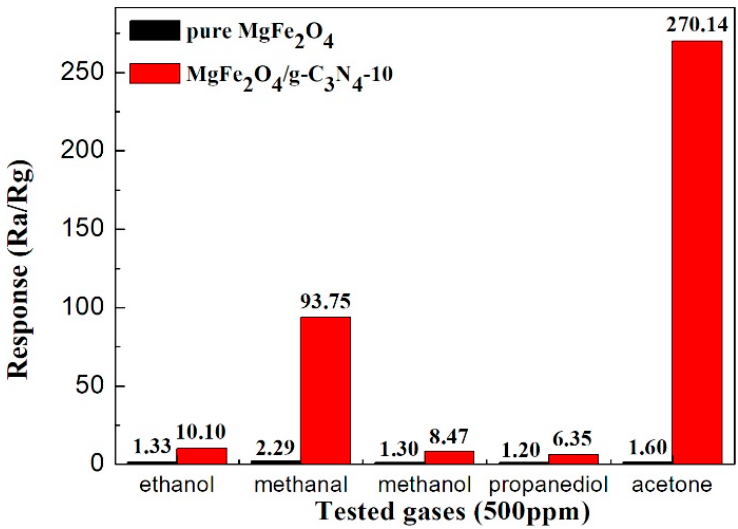
Figure 8. Response values of the sensors based on MgFe 2 O 4 and MgFe 2 O 4 /g-C 3 N 4 -10 to 500 ppm of different types of tested gas at working temperature of 320 °C. Sensors 2018 , 18 , x FOR PEER REVIEW 8 of 11